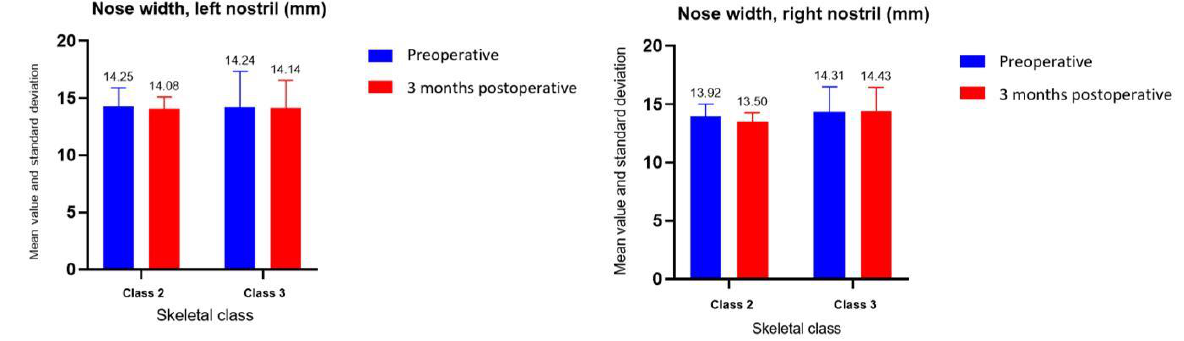
Figure 10. Nose width assessment, right and left nostrils.